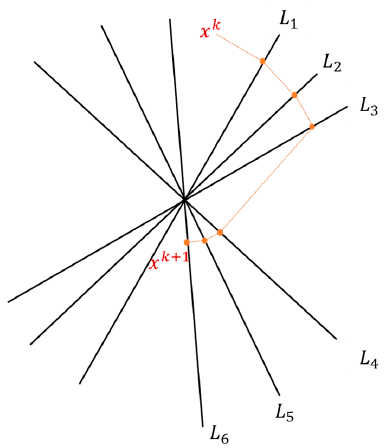
Figure 3. Kaczmarz’s Method.